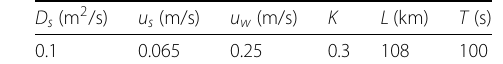
Figure 1 The exact solution of simulation 1 by (cid:4) x = 0.1 and (cid:4) t = 0.05 for all 0 ≤ x ≤ 108 and